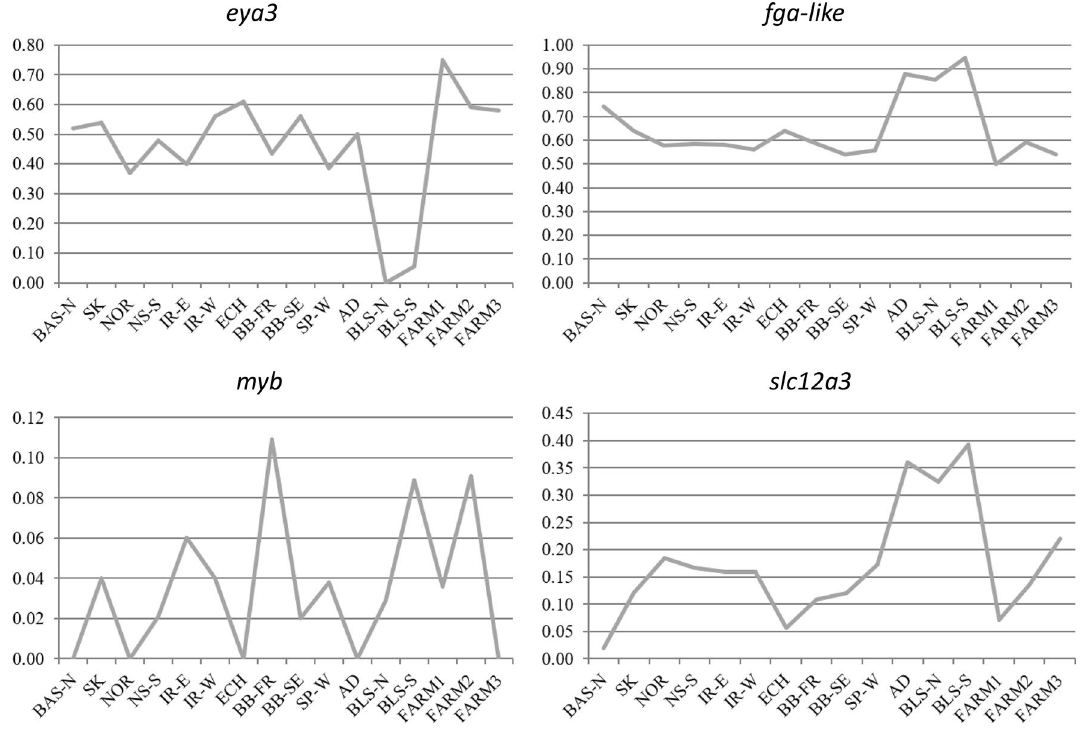
Figure 3. Allele frequency variation for some representative loci including non-synonymous variants evaluated across the whole distribution range and the main farm broodstock of turbot ( Scophthalmus maximus ).